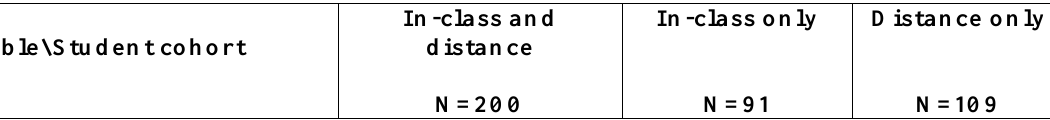
Summary of Research Findings for In-class and Distance Cohorts (Combined and Separate)